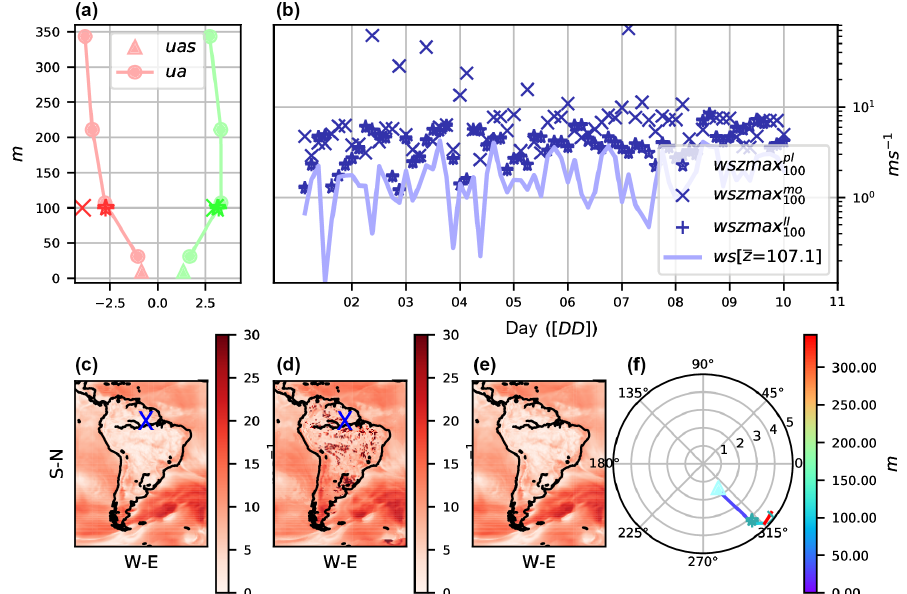
Figure 6. 100m wind estimates. Comparison between upper-level winds and estimation on 9 December 2012 at 15:00UTC at 62 ◦ 4 (cid:48) 38.00 (cid:48)(cid:48) S, 4 ◦ 58 (cid:48) 55.51 (cid:48)(cid:48) W. (a) 3h maximum eastward wind (red) at 100m by power law (uzmax pl , star marker), Monin–Obukhov theory (uzmax mo , cross), by logarithmic law (uzmax ll , sum), 10m wind value (uas, filled triangle), and upper-level winds (ua, filled circles with line), also for the northward component (green). Temporal evolution of wind speed (b) with all approximations and upper-level winds at the closest vertical level at 100m (on a log y scale, z = 107 . 1 m on average). Maps of three estimations: power law (c) , Monin–Obukhov (d) , and logarithmic law (e) , with the blue cross showing the point of previous figures. Vertical distribution of winds at the given point in a wind-rose-like representation (f)